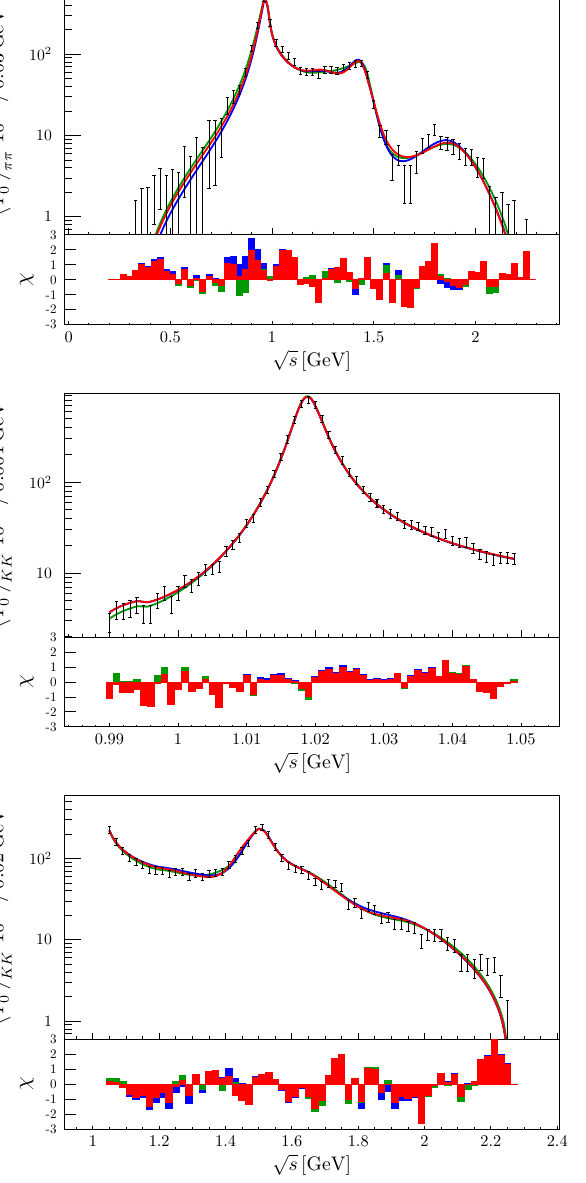
Fit 2 in red, and Fit 3 in green. On the lower axis we show the fit residuals defined by χ =